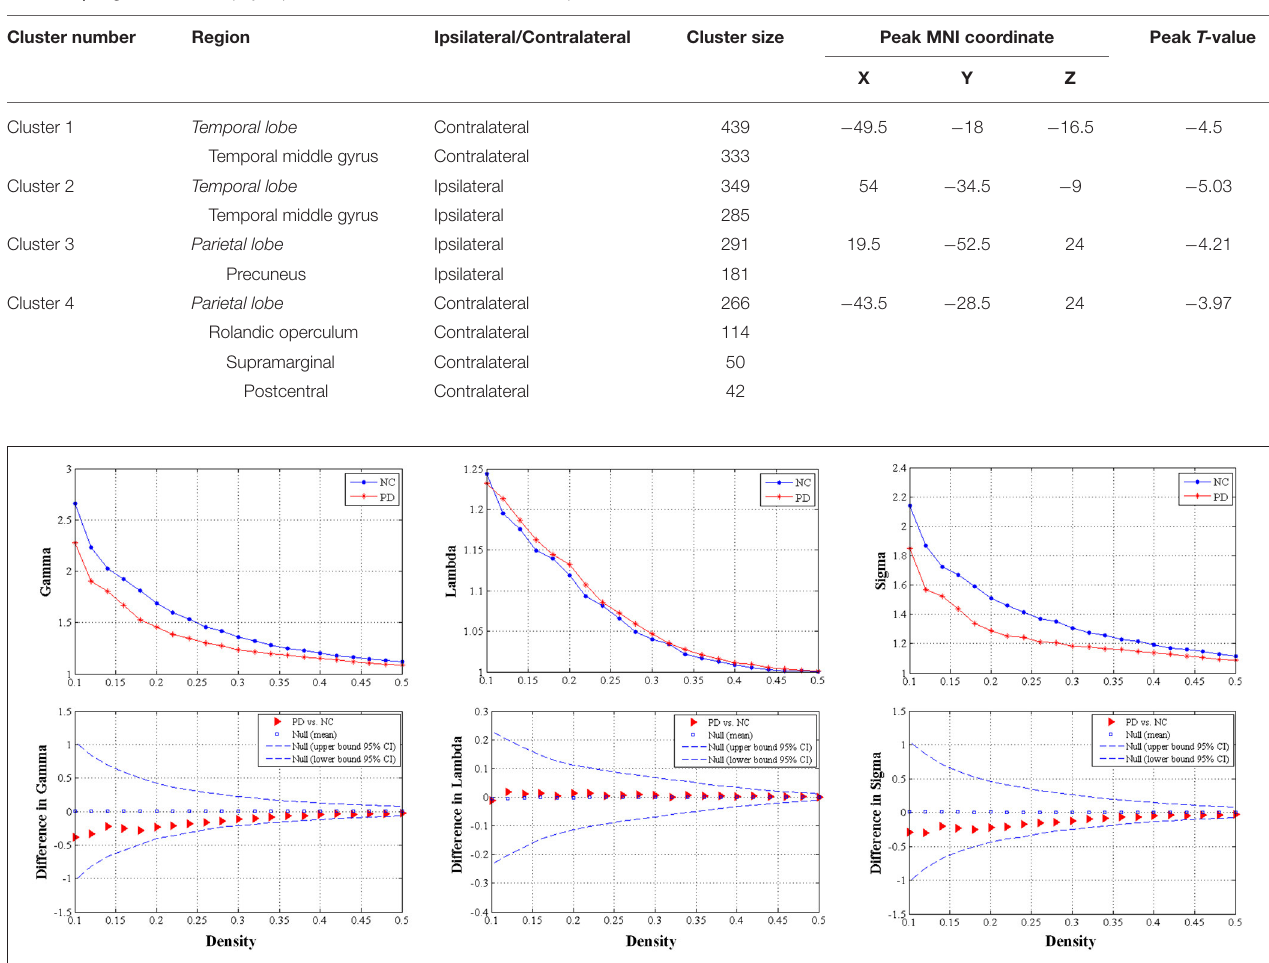
FIGURE 3 | The distributions (upper row) and intergroup differences (bottom row) of small-worldness including Gamma, Lambda and Sigma in/between normal controls and PD patients with hemiparkinsonism. The upper and lower 95% confidence intervals were shown with dotted line in the bottom row. Thus, no significant difference was observed between